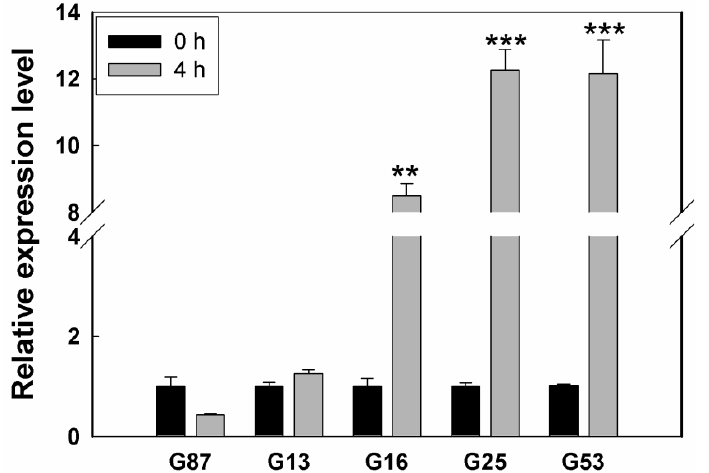
Figure 9. Expression analysis of LcSAIN3 in sheepgrass germplasms with different salt tolerance. G53, G25 and G16 are salt tolerant germplasms, and G13 and G87 are salt sensitive germplasms. ***, and ** indicate significant differences in comparison with the control at p < 0.001, and p < 0.01, respectively.